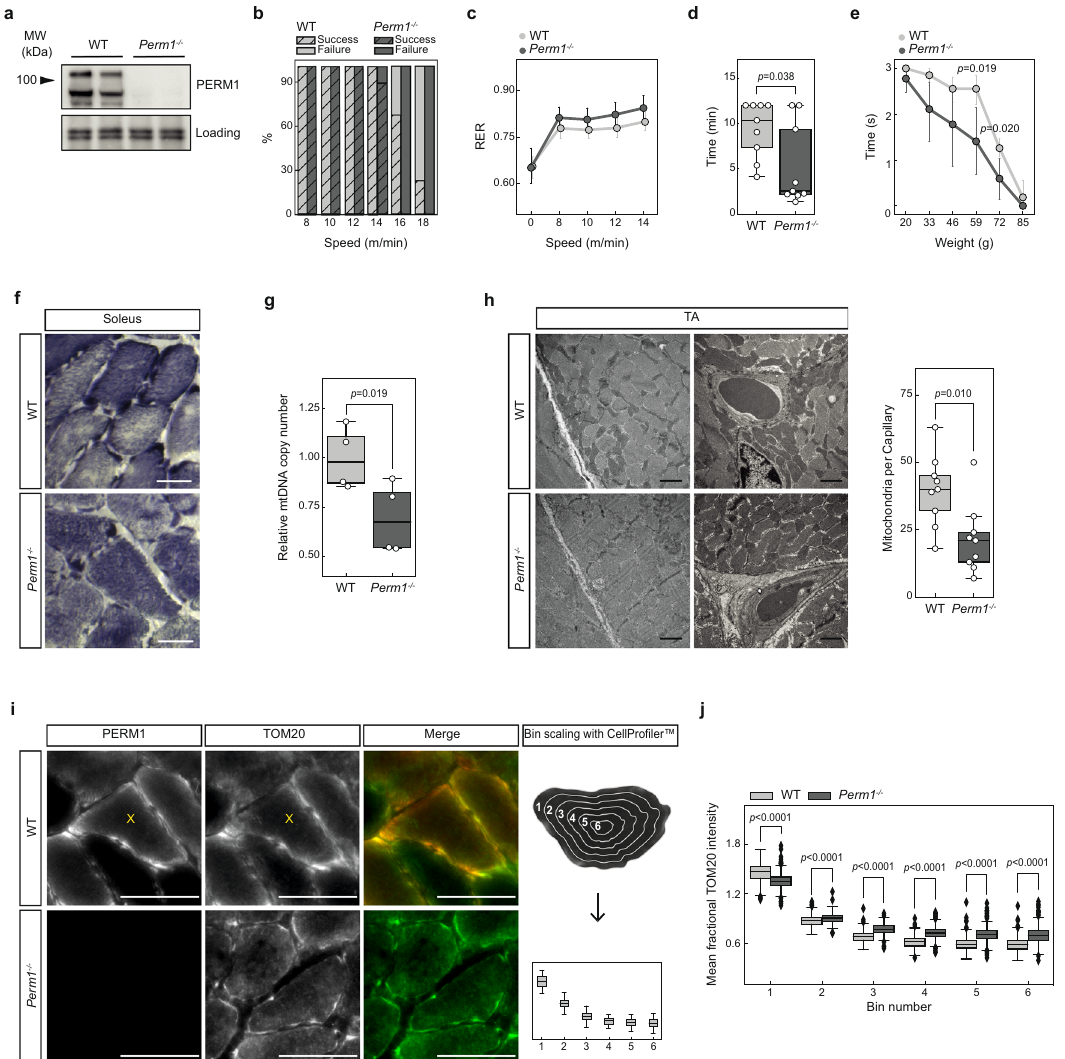
Fig. 1 Deletion of Perm1 reduces muscle force and alters the localization of subsarcolemmal mitochondria. a Western blot depicting successful depletion of Perm1 in Perm1 − / − TA muscle. Correct genotype was con fi rmed by western blotting for each mouse used in the whole study ( n > 20 mice per group). b , c Forced running experiments with metabolic respiratory exchange ratio (RER) measurements. b Percentage of wild-type and Perm1 − / − mice that succeeded or failed to run at the indicated speed for two minutes each ( n = 9 mice per group). c RER (VCO 2 /VO 2 ) of wild-type and Perm1 − / − mice running at the indicated speed ( n = 9 mice per group). d Inverted screen test; the time Perm1 − / − and wild-type mice held their body weight on an inverted grid is shown ( n = 9 mice per group). e Weight test; the time Perm1 − / − and wild-type mice grasped increasing weights is shown ( n = 9 mice per group). f Succinate dehydrogenase (SDH) of soleus muscle from Perm1 − / − mice indicated an altered overall distribution of mitochondria compared to wild-type control. Scale 25 µ m. g qPCR analysis showed decreased in mtDNA copy number in Perm1 − / − soleus muscle compared to wild-type controls ( n = 3 mice per group). h Left: Electron microscopic inspection of TA muscle showed decreased mitochondrial density at capillaries in Perm1 − / − mice compared to wild-type mice. Scale 1 µ m. Right: Number of mitochondria per capillary in Perm1 − / − and wild-type mice ( n = 2 mice per group, 10 quanti fi ed capillaries). i Immunohistochemical staining of soleus muscle indicated co-localization of PERM1 (red) with TOM20 (green). Scale 50 µ m. Schematic visualization of bin scaling of a single muscle fi ber for TOM20 intensity quanti fi cation. j Mean fractional intensity of TOM20 signals in bins 1 – 6 from Perm1 − / − and wild-type soleus muscle fi bers. Intensity is reduced at subsarcolemmal sites and increased within inter fi brillar mitochondria in Perm1 − / − muscles compared to wild- type control ( n = 2 mice per group, 507 quanti fi ed fi bers). Data ( c , e ) are presented as mean values ±0.95 CI. Box plots ( d , g , h , j ) represent the median, 25th, and 75th percentiles, maximum and minimum are connected through whiskers, and individual data points are added on top ( d , g , h ). Outliers are de fi ned as Q 1 − 1.8 interquartile range (IQR) and Q 3 + 1.8 IQR. ( c – e , g , h ) unpaired two-sided Student ’ s t test, ( j ) unpaired two-sided Mann – Whitney U -test. Source data are provided as Source Data fi in vivo muscle stimulation experiments demonstrated that loss of upwards compared to controls (Fig. 1e). Next, we measured the PERM1 leads to reduced muscle strength and endurance. Thus, it force generated by the gastrocnemius muscle in living animals will be interesting to investigate effects of Perm1 deletion on force after electrical stimulation. Perm1 − / − exhibited reduced strength development in individual muscle groups with different fi ber compared to controls at all stimulation frequencies, although the types and explore how PERM1 affects mitochondrial activity differences did not reach statistical signi fi cance ( p -value 0.09; SI under normal and exercise conditions. Fig. S1e). Overall, the running performance, muscle strength and